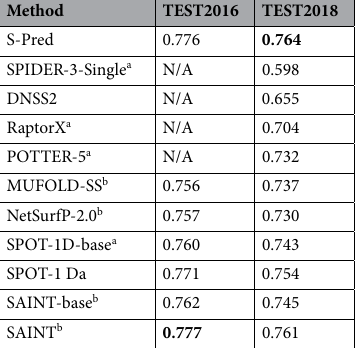
Table 1. Comparison of the SS8 accuracy obtained from several methods on the TEST2016 and TEST2018 datasets. The data acquired from other methods except DNSS2 were obtained from Hanson et al . 8 and Uddin et al . 11 . The method that performs the best is represented in bold. a Data adapted from Hanson et al. 8 . b Data adapted from Uddin et al. 11